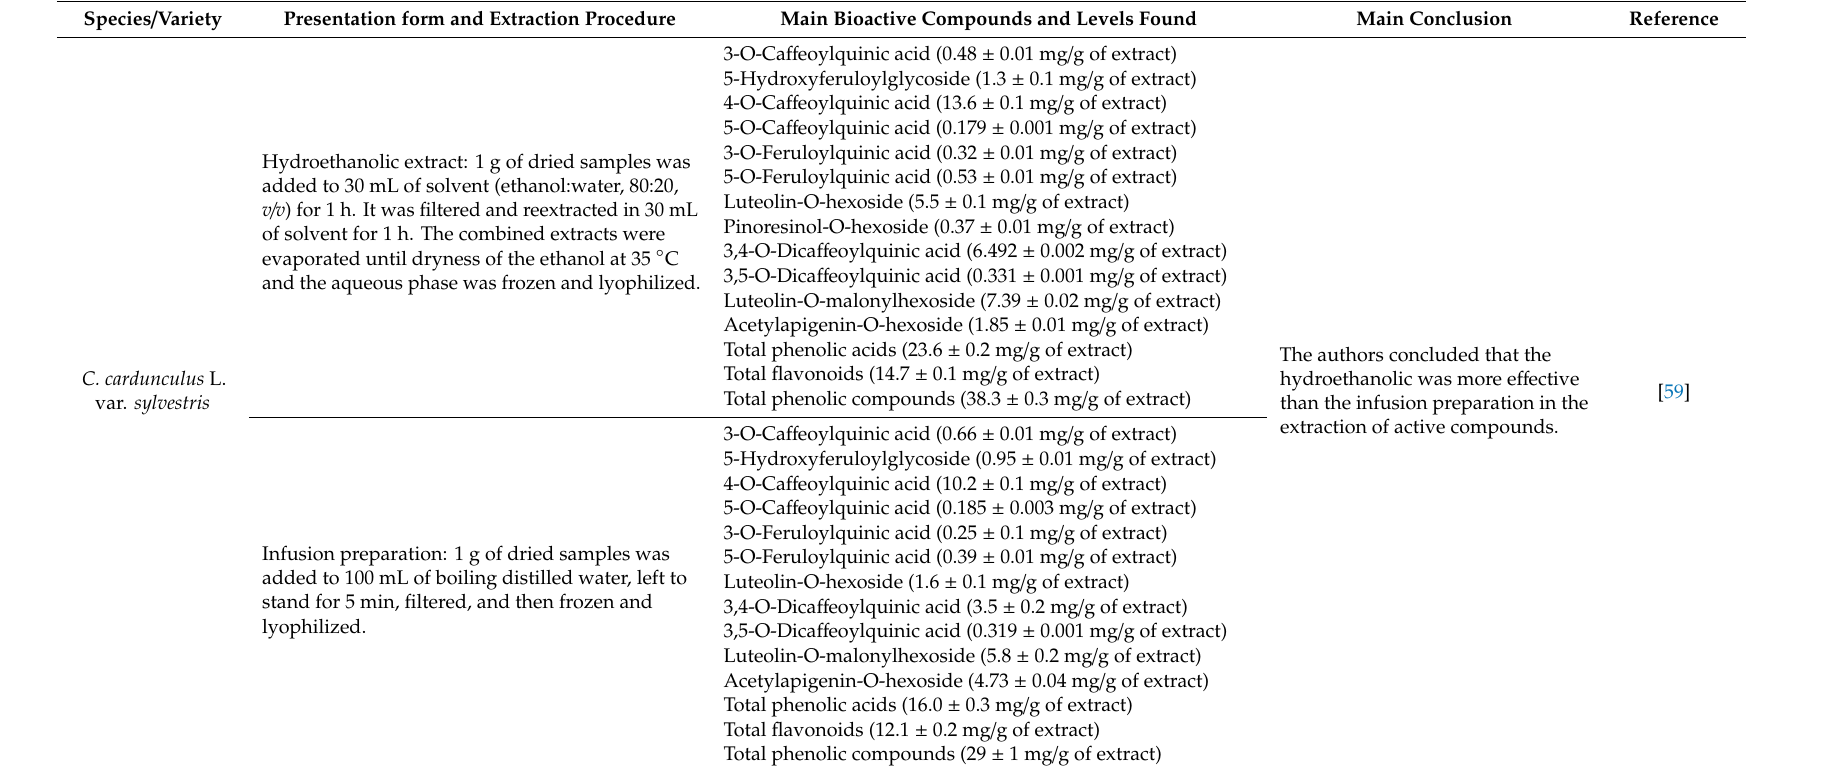
Table 1. Main bioactive compounds of cardoon